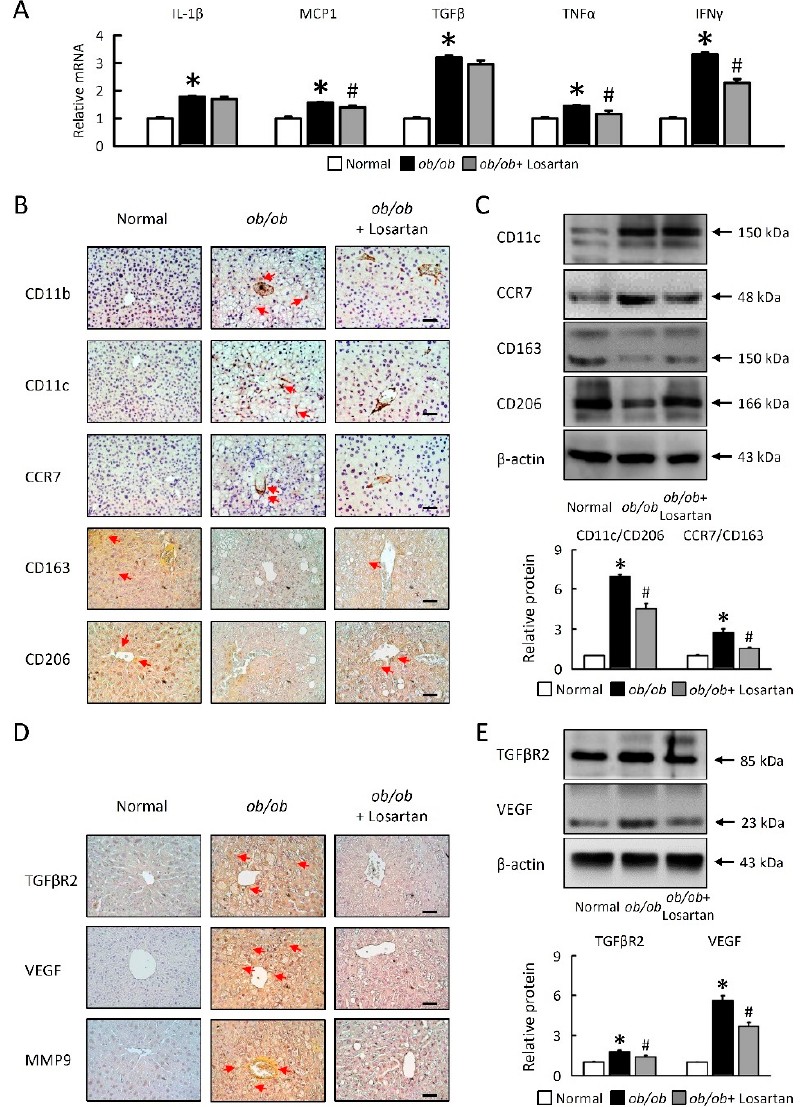
Figure 5. Losartan related macrophage polarization and angiogenesis in liver. ( A ) Quantification of IL-1 β , MCP-1, TGF β , TNF α , and IFN γ by qRT-PCR. qRT-PCR indicates quantification relative to GAPDH. ( B ) Representative CD11b, CD11c, CCR7, CD163 and CD206 staining of liver. Red arrow highlights the positive staining. Scale bar: 100 μ m. ( C ) Quantification of CD11c, CCR7, CD163, and CD206 protein levels by Western blot of liver. Below graphs indicate quantification relative to β -actin. Ratio of CD11c at CD206 and CCR7 at CD163 in liver. ( D ) Representative TGF β R2, VEGF, and MMP9 staining of liver. Red arrow highlights the positive staining. Scale bar: 100 μ m. ( E ) Quantification of TGF β R2 and VEGF protein levels by Western blot of liver. Below graphs indicate quantification relative to β -actin. For each animal group, n = 5. All values represent the mean ± SEM. Data were analyzed by Student’s t test. * p ≤ 0.05; normal vs. ob / ob . # p ≤ 0.05; ob / ob vs. ob / ob + Losartan. IL-1 β , interleukin-1 β ; MCP-1, monocyte chemoattractant protein-1; TGF β , transforming growth factor beta; TNF α , tumor necrosis factor α ; IFN γ , interferon gamma; TGF β R2, transforming growth factor beta receptor 2; VEGF, targets vascular endothelial growth factor; MMP9, matrix metallopeptidase